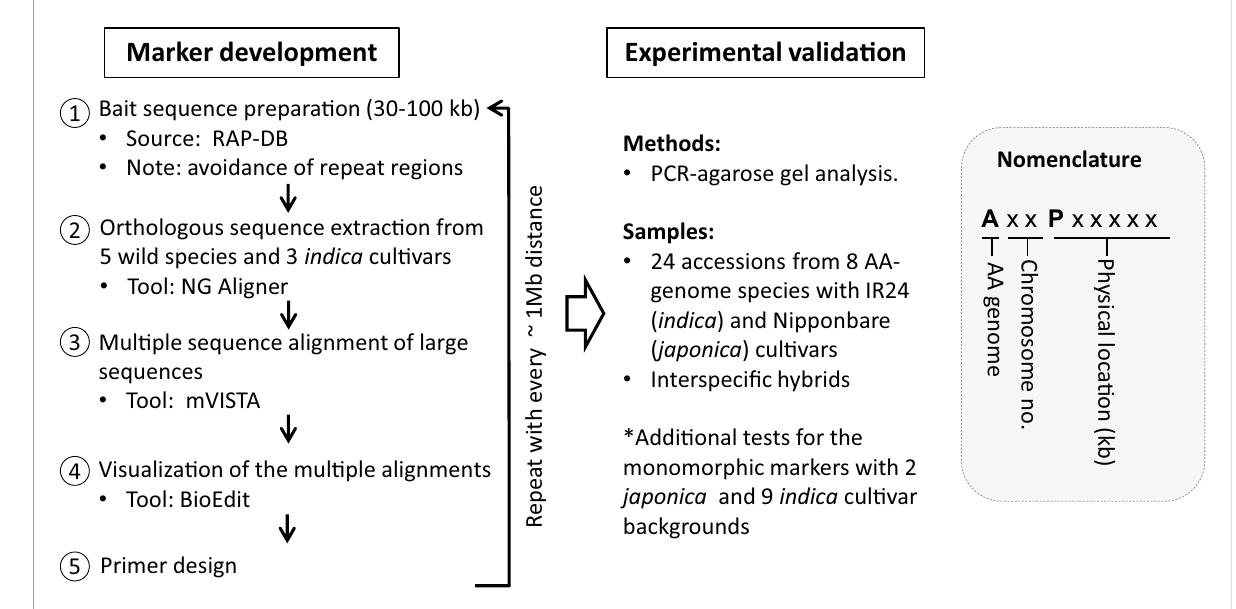
Figure 1. Strategy for the development of a genome-wide InDel marker set for allele discrimination between O. sativa and other AA-genome species in the genus Oryza